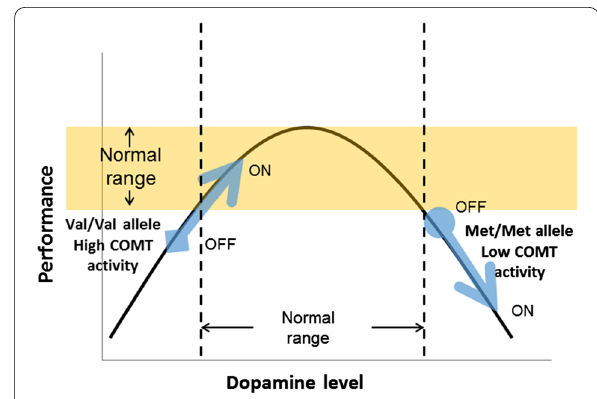
Fig. 2 Inverted U-shaped curve relationship between striatal dopamine level and the behavioral, cognitive performance. The effect of dopaminergic treatment (OFF: without medication, ON: with medication) in the cognitive performance differs by the baseline striatal dopamine level and the catechol-O-methyl transferase (COMT) activity, depending on its gene